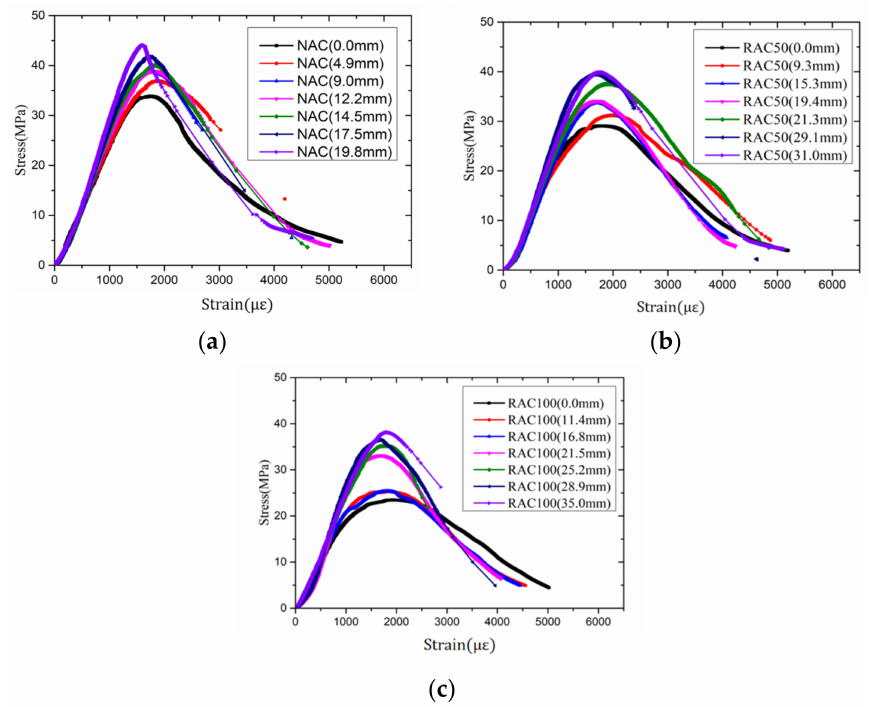
Figure 7. Uniaxial stress–strain curves of the specimens with different carbonation depth. ( a ) NAC; ( b ) RAC50; and ( c )